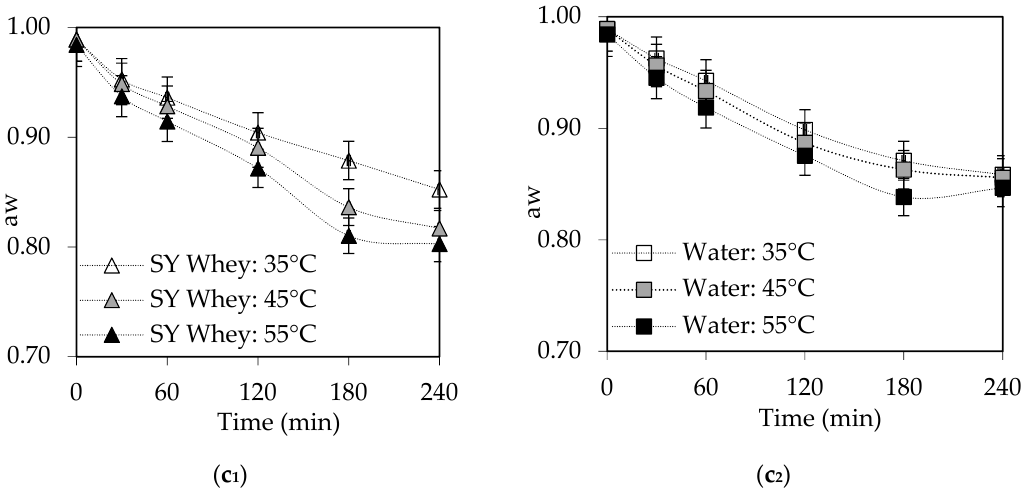
Figure 1. ( a ) Water loss ( WL , g water / g i.d.m.), ( b ) solid gain ( SG , g solids / g i.d.m.), and ( c ) water activity ( a w ) during osmotic dehydration of pumpkin cuts in solution of SY Whey or water (Index 1: OD SY Whey and Index 2: OD Water ), at temperatures T 35, 45, 55 °C for times t up to 240 min (average ± standard error or deviation). Table 1. Effective diffusion coefficients of water ( D ew × 10 − 9 m 2 /s) and solids ( D es × 10 − 9 m 2 /s) during osmotic treatment of pumpkin cuts for 240 min at 35, 45, and 55 °C. Samples: OD Water , OD SY Whey .